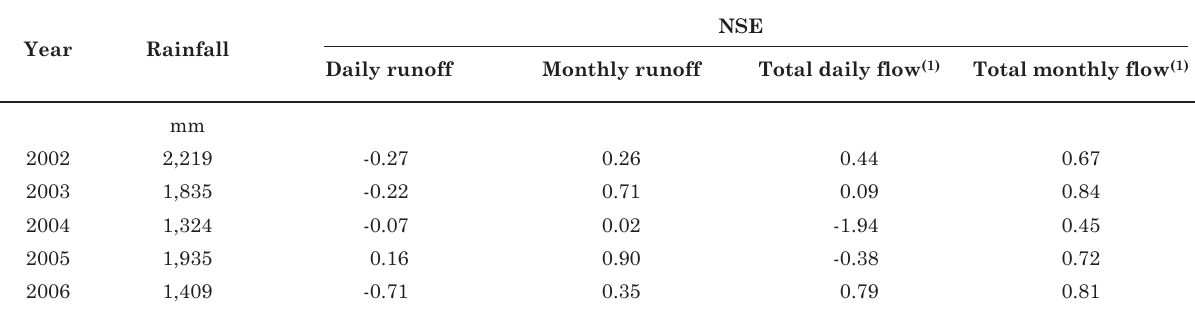
table 2. Values of rainfall and nse for surface runoff (daily and monthly) and total runoff (daily and monthly) obtained by the swat model